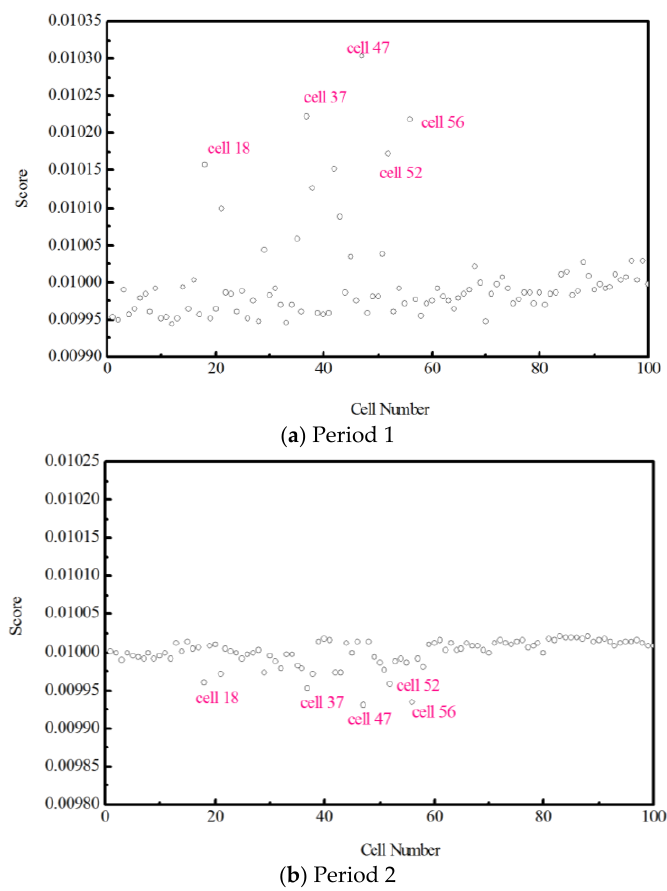
Figure 7. Scores of all cells at different periods. Table 2. ∆ s of Vehicle